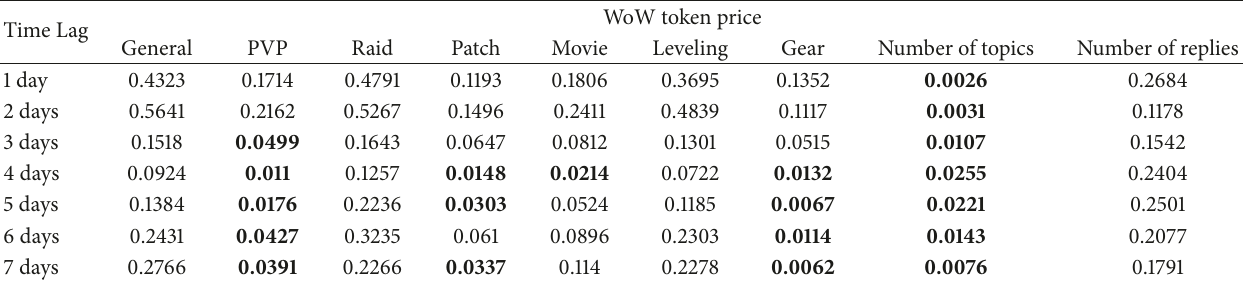
Table 4: Statistical significance ( 𝑝 values) of bivariate Granger causality test between WoW token price (EU Region) and concepts of forum